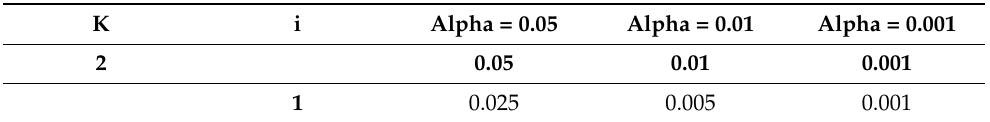
Table 4. Benjamini-Hochberg correction: Comparison of microRNA gene expression between preterm (delivery before 37 weeks of gestation) and normal term pregnancies (delivery after 37 weeks of gestation).